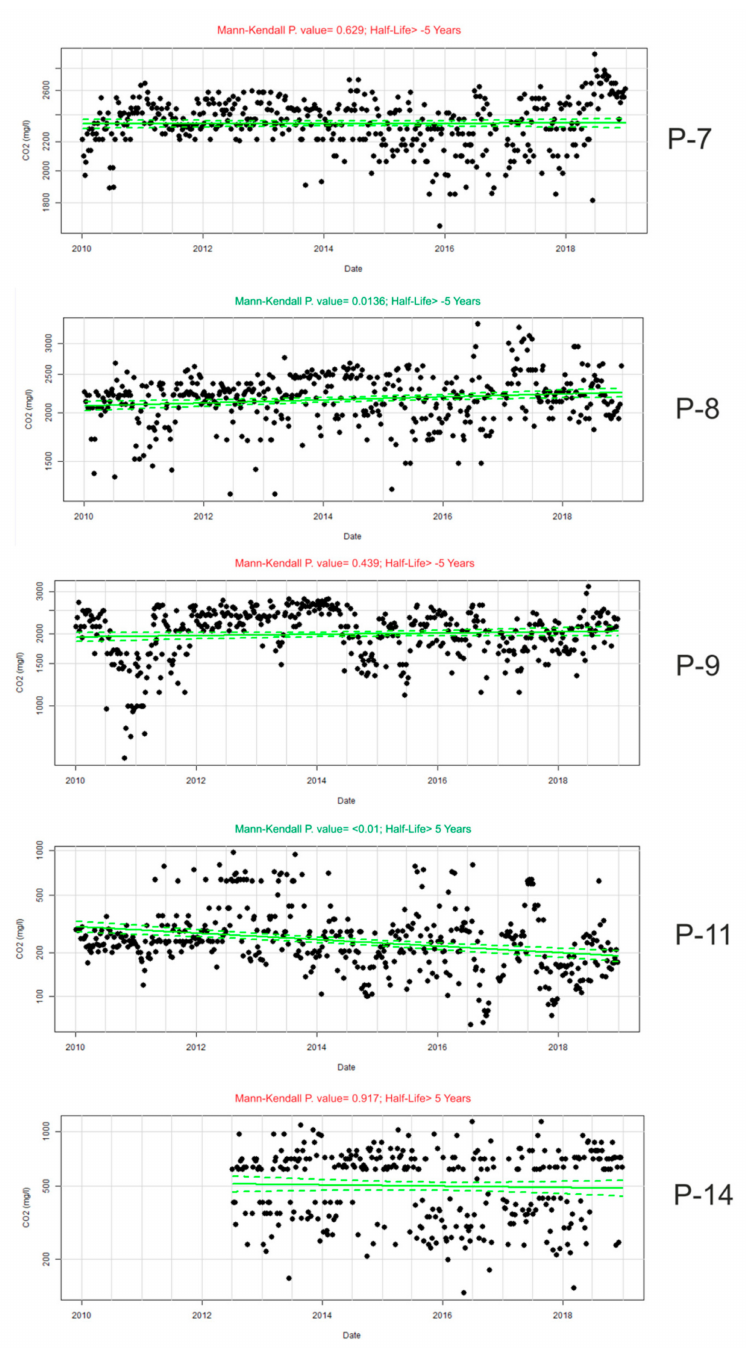
Figure 8. CO 2 trends in analysed boreholes [GWSDAT